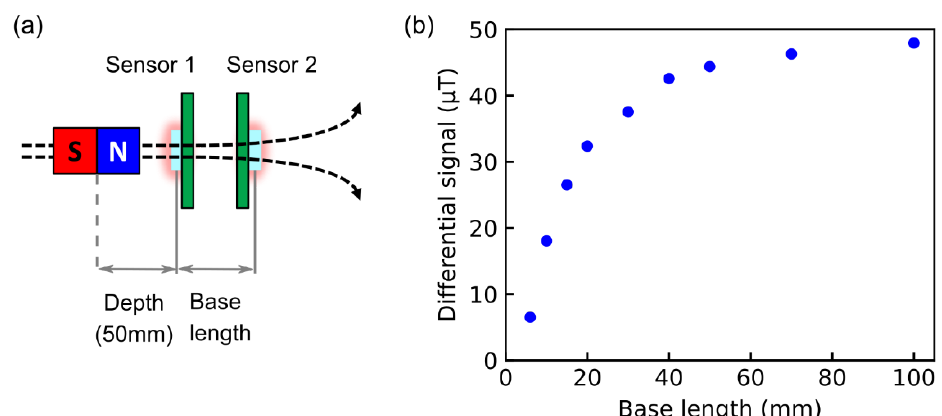
Figure 6. ( a ) Setup for measuring the base length dependence. Sensor 1 and sensor 2 are connected to optical fibers independently, allowing to change the base length freely. ( b ) Calculated differential signal level using the gradiometer as a function of the base length.